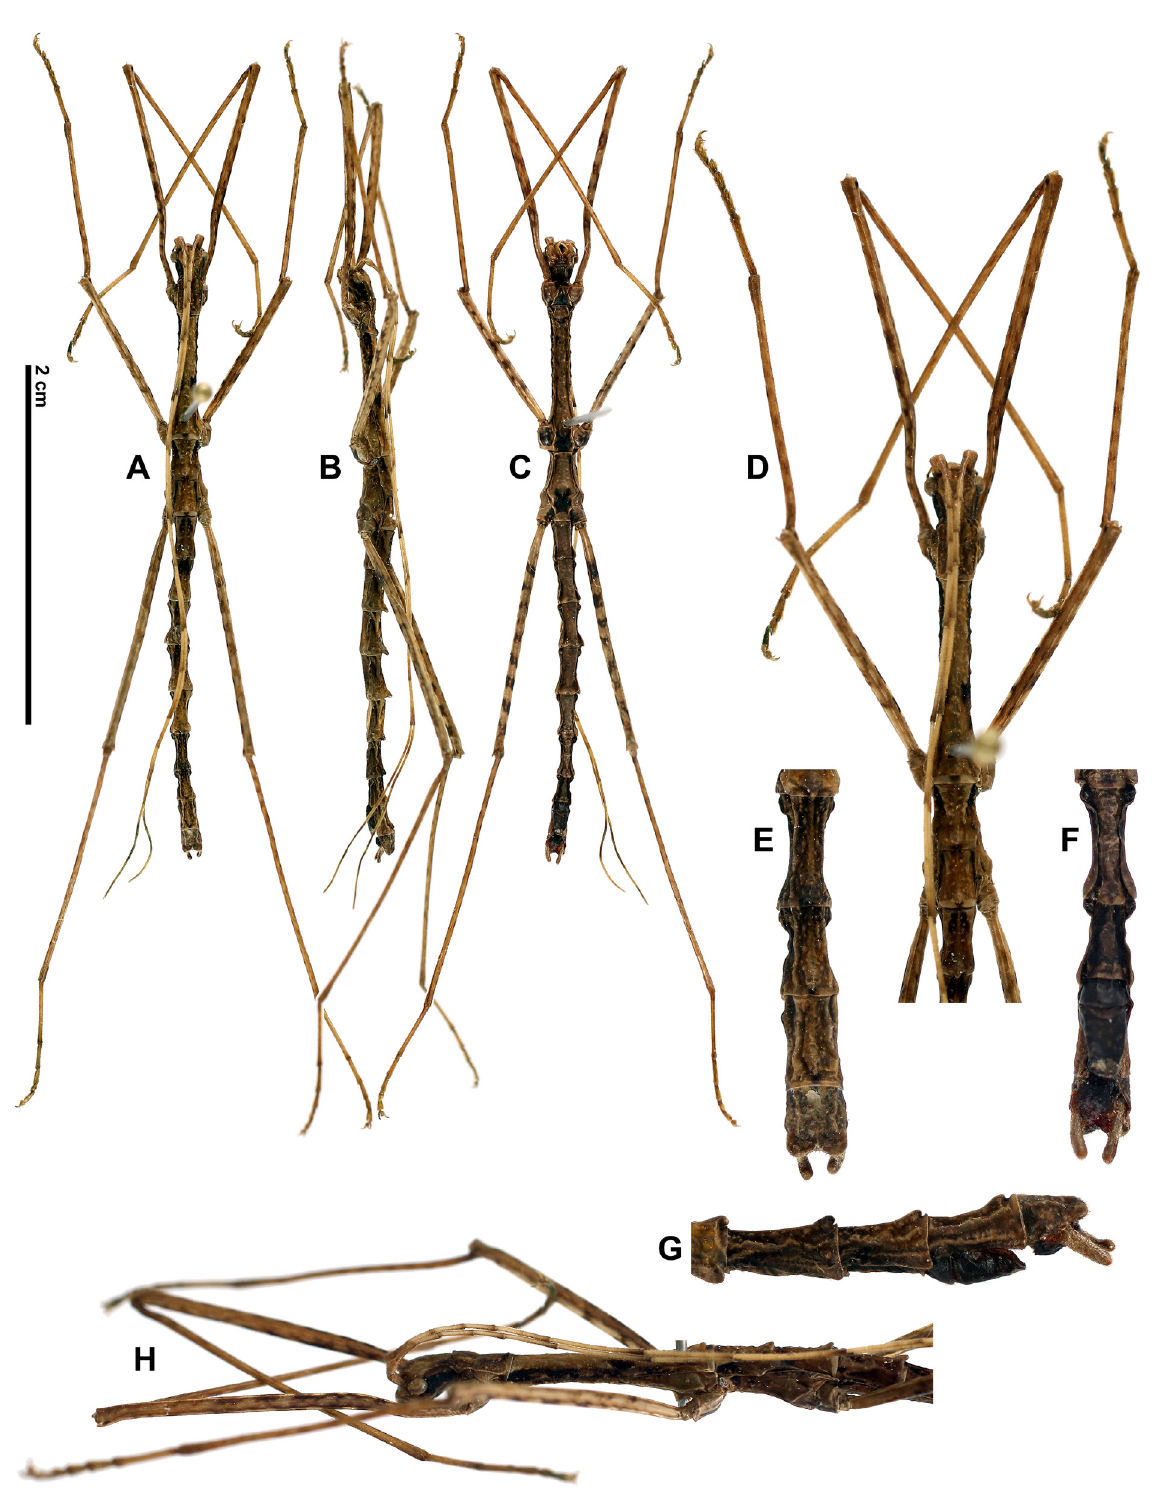
Fig. 11. Otraleus elizabethae sp. nov., ♂, holotype. A . Habitus, dorsal view. B . Habitus, lateral view. C . Habitus, ventral view. D . Anterior part of body, dorsal view. E . Apex of abdomen, dorsal view. F . Apex of abdomen, ventral view. G . Apex of abdomen, lateral view. H . Anterior part of body, lateral view. D–H: not to